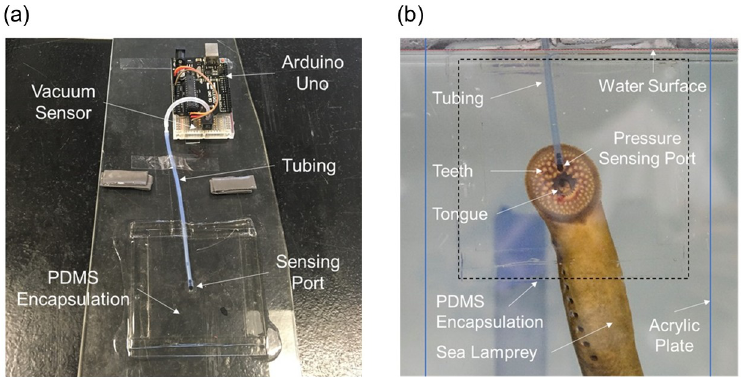
Fig 1. The single-port pressure sensing system used to measure oral suction pressures of sea lamprey, Petromyzon marinus . (a) The single-port sensing panel with a port on the acrylic plate encapsulated with polydimethylsiloxane (PDMS) and connected to the vacuum sensor beside the Arduino Uno microcontroller board via soft tubing, and (b) an adult sea lamprey attached to the sensing panel at the sensing port in a water-filled